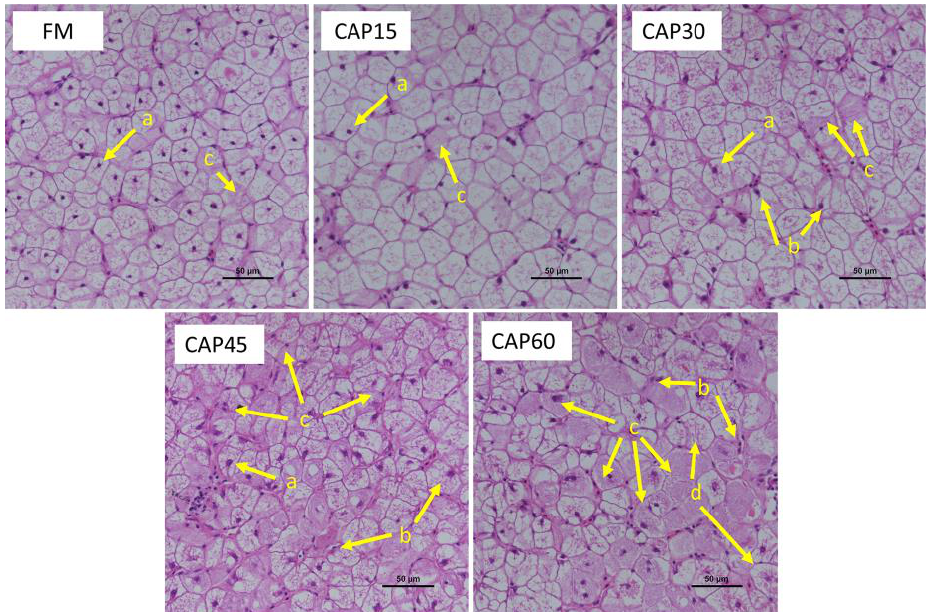
Figure 3. Histological appearance of liver stained with HE of pearl gentian grouper-fed gradient